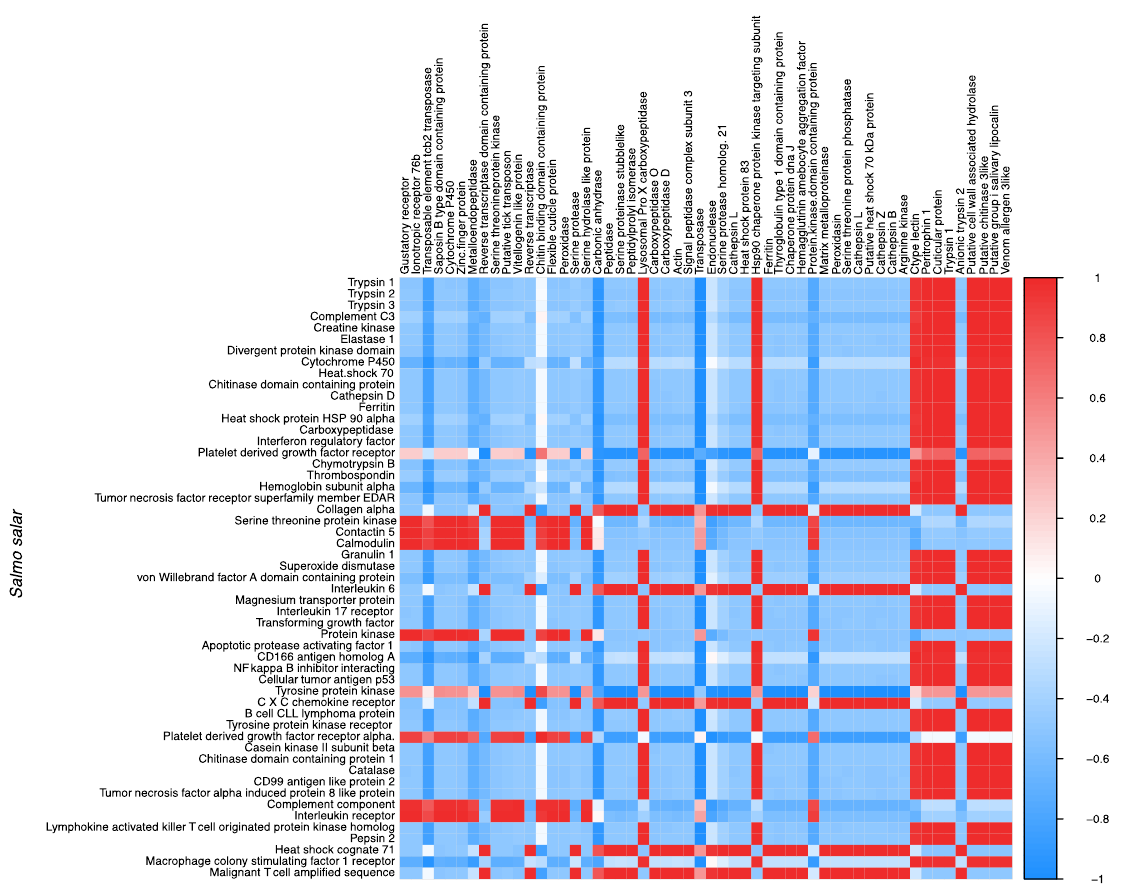
Figure 5. Correlation between the differentially expressed genes (DEGs) of the Peritrophin, Cathepsin, and P/C vaccine prototypes. The genes of S. salar and C. rogercresseyi are shown on the Y and X axes. The matrix shows the correlation coefficients between the TPM values of the DEGs of S. salar and C. rogercresseyi . Red and blue colors indicate significant correlations (significant positive or negative correlations, respectively).